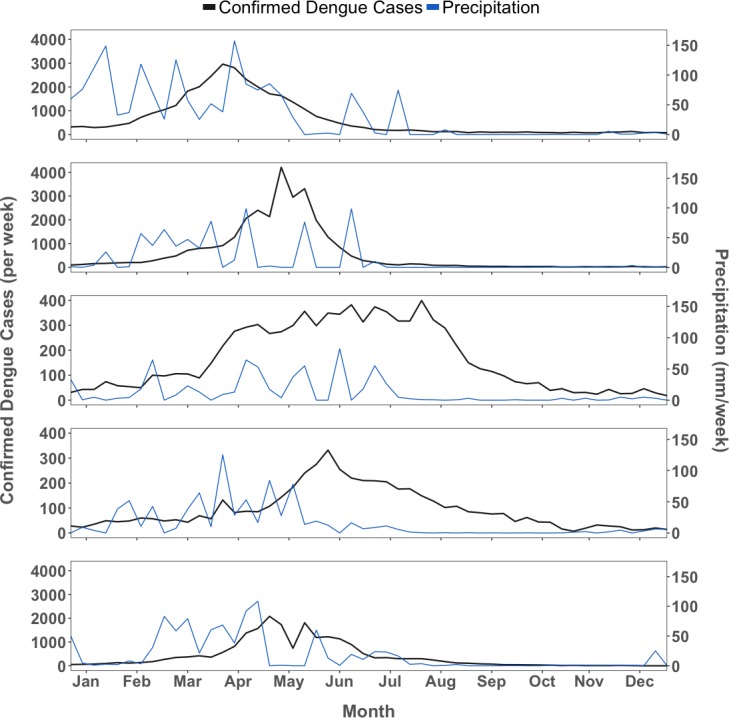
Dengue epidemiological curves and weekly precipitation, Fortaleza, 2011–2015.Average precipitation by week is presented in blue. Line of weekly dengue case count citywide is presented in black. Scale is adjusted for dengue cases (left y-axis) between interepidemic (2013, 2014) and epidemic years (2011, 2012, 2015), and constant for precipitation (right y-axis).